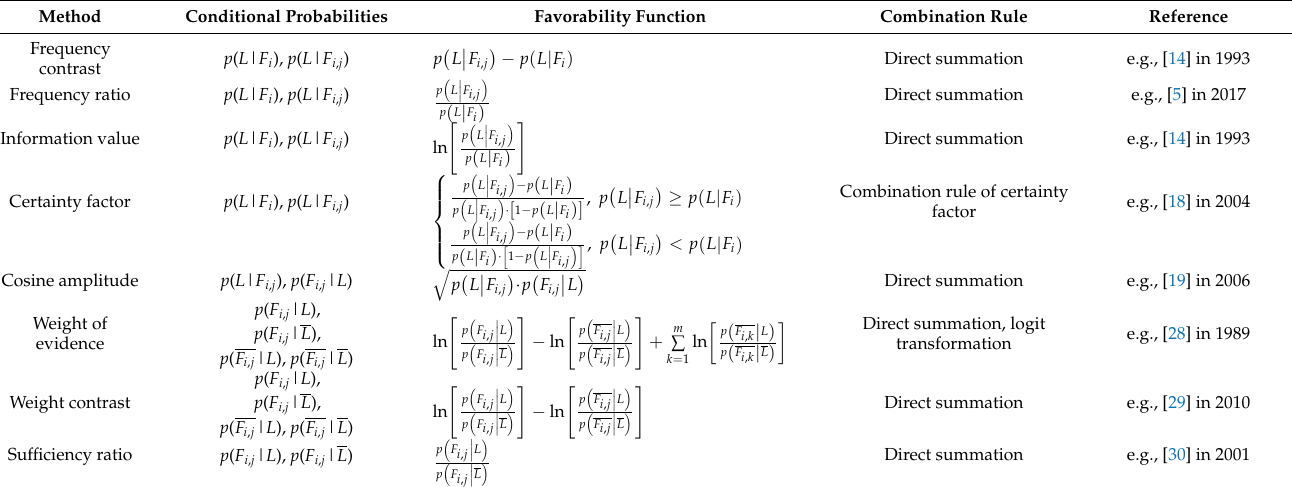
Table 1. Summary of conditional-probability-based bivariate methods of landslide susceptibility